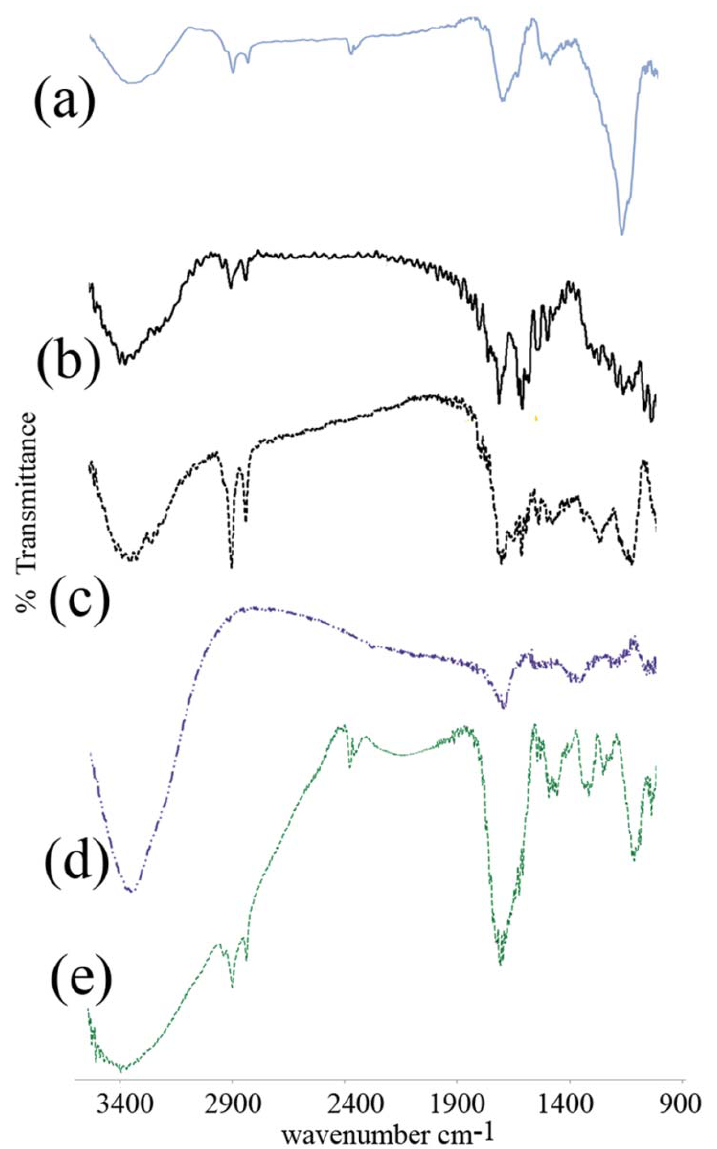
Figure 3. Comparison of Fourier Transform Infrared Spectroscopy (FTIR) spectra of each